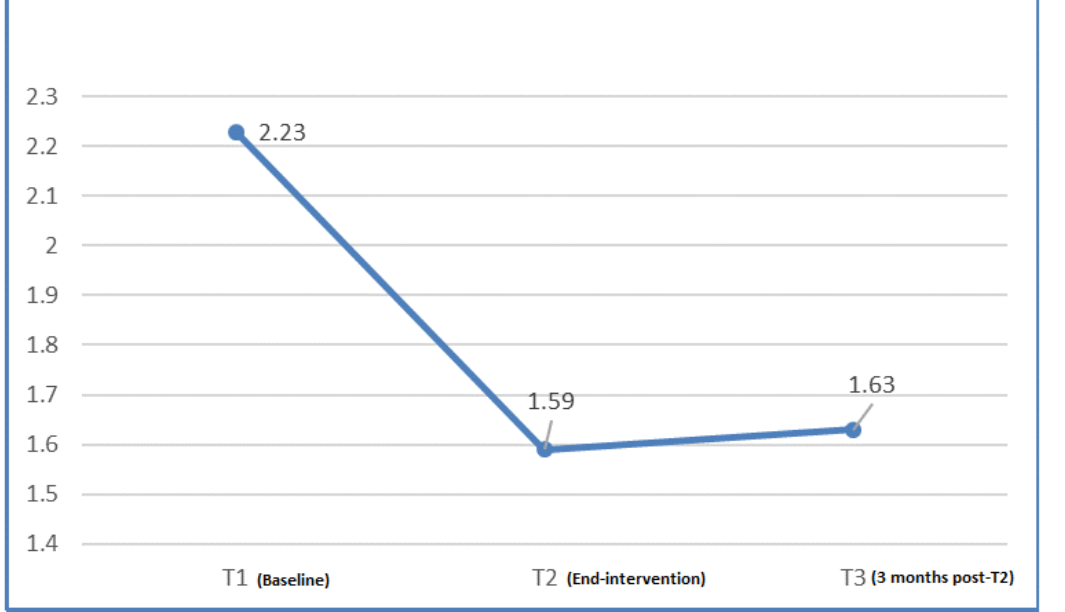
Figure 6. Changes in mean total diabetes distress scale (DDS)